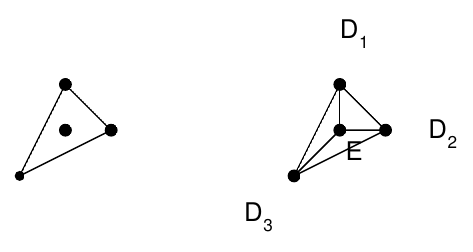
Figure 4 . One toric diagram and its crepant